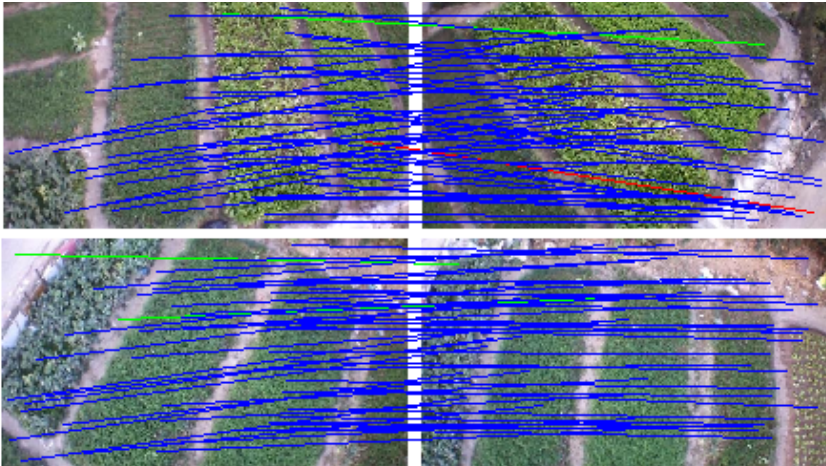
Figure 1. Experimental results on two typical image pairs of nonrigid objects. The lines indicate mismatch removal results (blue = true positive, green = false negative, red = false positive). For visibility, in the image pairs, only 50 randomly selected correspondences are presented, and the true negatives are not shown. Table 1. The precision (P) and recall (R) results of different methods on the image pairs in Figure 1. The initial inlier percentage is 37.27% and 42.39% on the two image pairs,